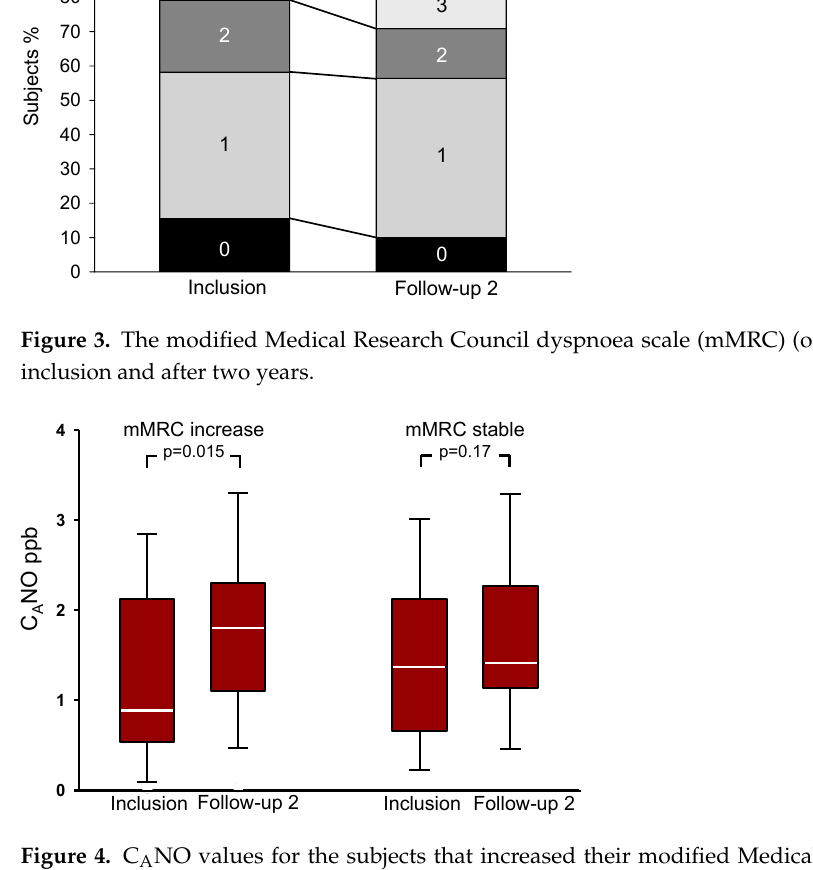
Figure 4. C A NO values for the subjects that increased their modified Medical Research Council dyspnoea scale (mMRC) by 1–3 points (n = 32, left) and the subjects that had a stable mMRC, minus 1 or the same value (n = 78, right) at inclusion and after two years. The horizontal line in each box corresponds to the median value, the upper and lower margins correspond to Q1 and Q3, and the whiskers correspond to the 10th and 90th percentiles.